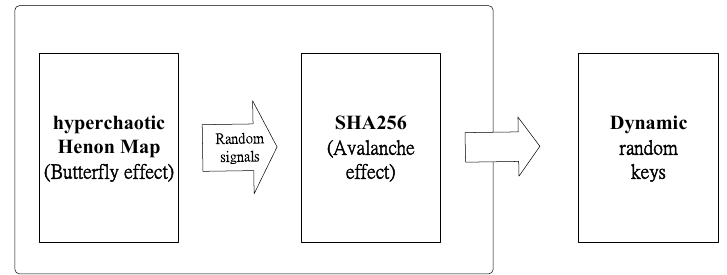
Figure 5. The dynamic random key generator with SHA256.